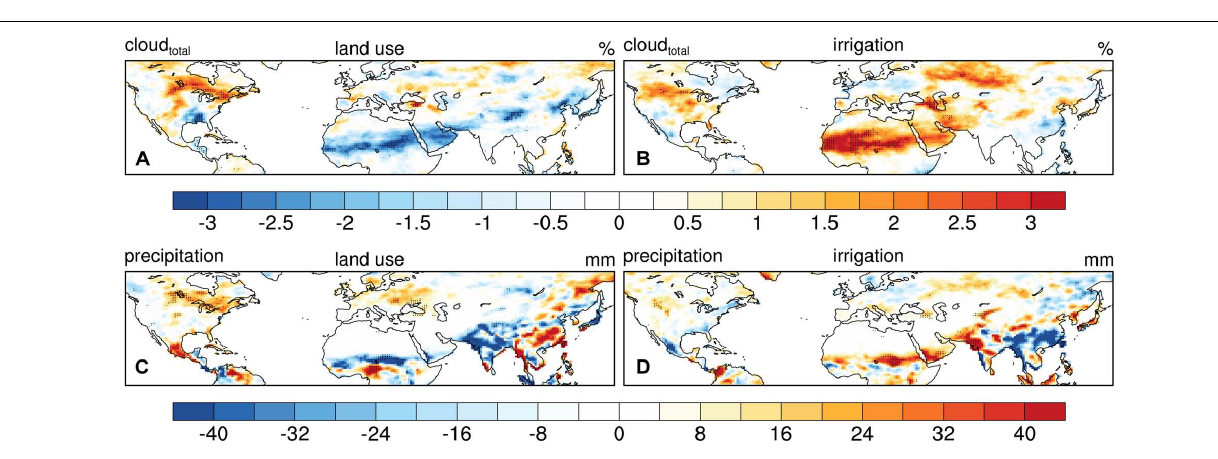
FIGURE 6 | Changes in summer monthly mean cloud cover [in %, (A,B) ] and total precipitation [in mm, (C,D) ] due to historical land use (left) and irrigation (right). Stippling indicates significance at the 95% confidence